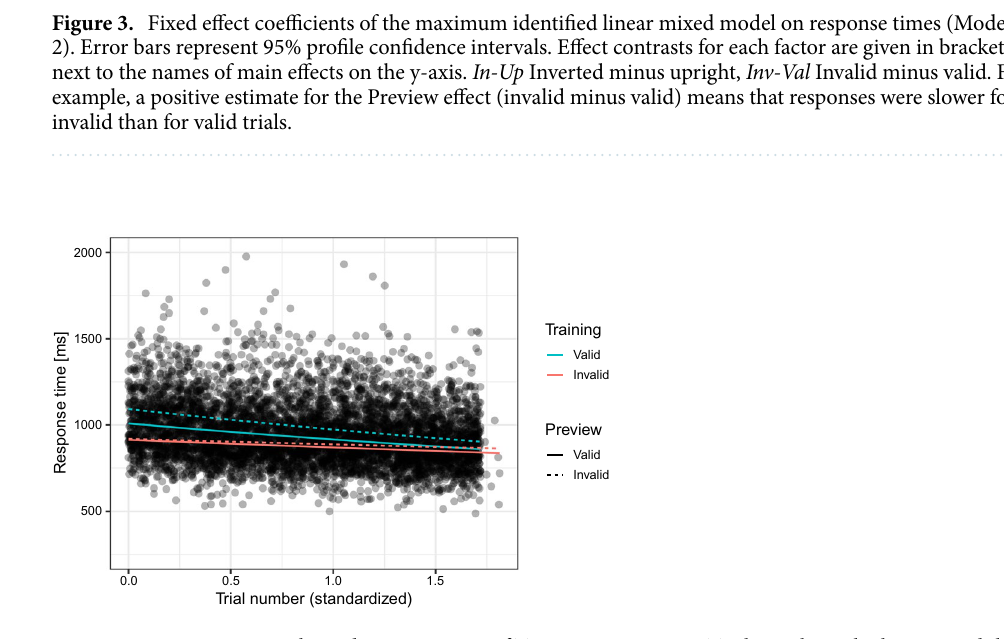
Figure 4. Response times showed an interaction of Training × Preview × Trial Number, which suggested that training with only valid trials resulted in a larger preview effect than training with only invalid trials particularly in the beginning of the test phase (Model 2). The preview effect then evolved in opposite directions for both training groups. Compared to the invalid training group, the preview effect in the valid training group declined. Dots represent a random sample of half of all individual data points. Trial number was standardized and centred on the first trial of the test